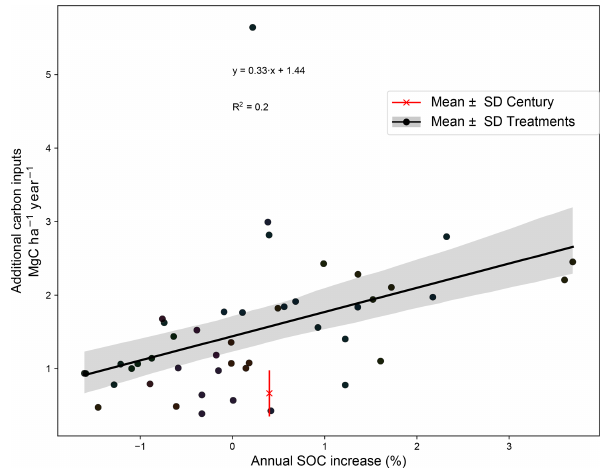
Figure 5. Correlation between additional carbon inputs (MgCha − 1 per year) and annual SOC stock increase (%) in the carbon input treatments and mean ± standard deviation of the additional carbon inputs to reach the 0.4% target in